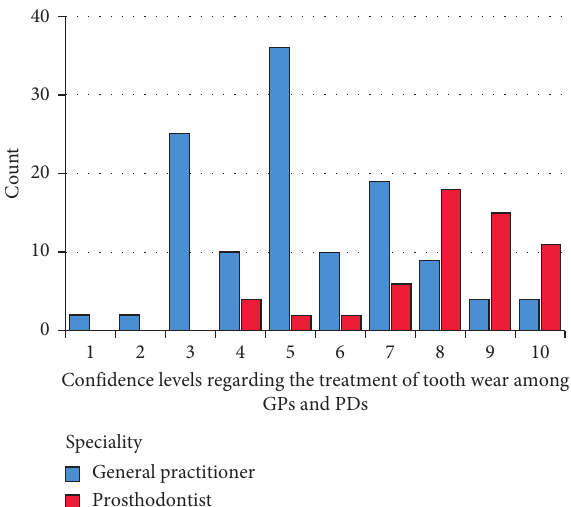
Figure 5: The frequency of confidence levels of GPs and PDs regarding the treatment of tooth wear on a 10-point VAS